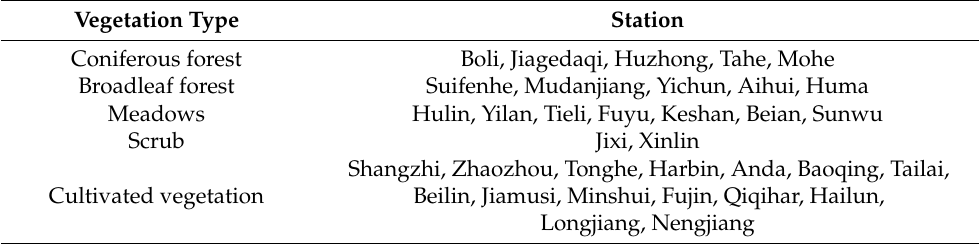
Table 1. Classification of vegetation types at each